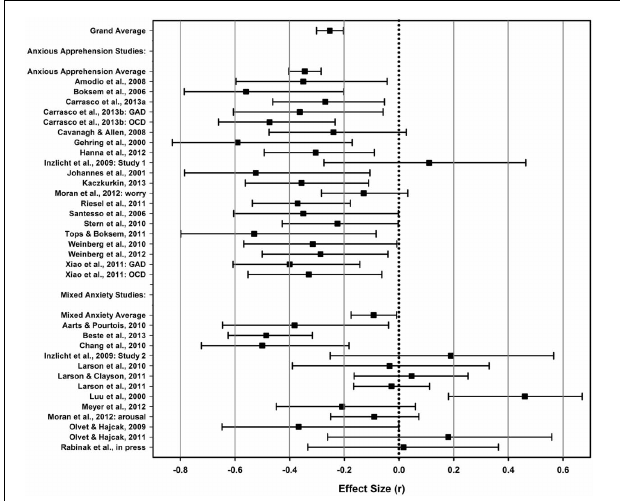
FIGURE 3 | ERN forest. A forest plot depicting effect sizes ( r ) between the ERN and measures of anxiety for the meta-analytic average (top), the anxious apprehension and mixed anxiety averages, and individual studies. Error bars depict the 95% confidence interval for the effect size. The dotted line indicates an effect size of 0.